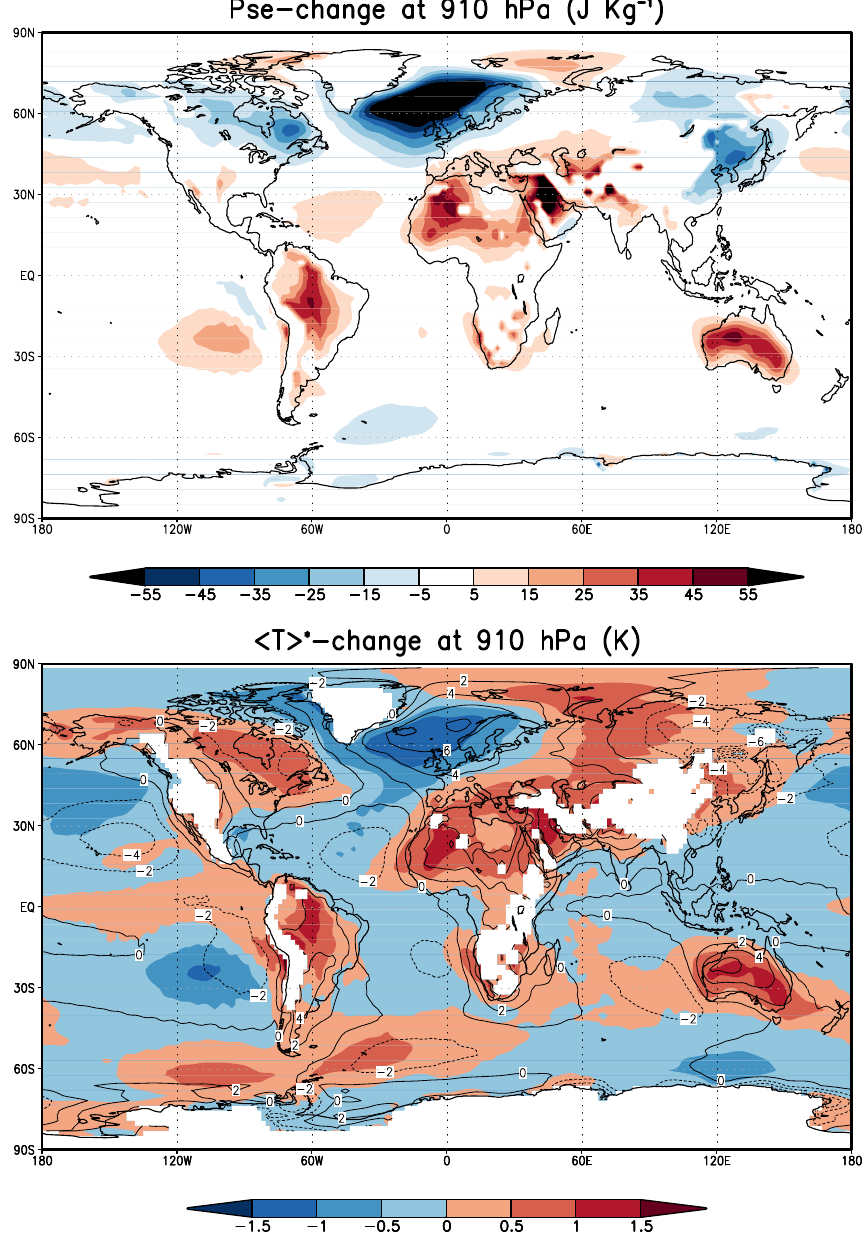
Fig. 9. P se -change (upper panel) and h T i ∗ -change, the changes in the zonal anomalies of temperature (lower panel) at 910hPa due to CO 2 doubling. Contour lines in lower panel indicate the 1 × CO 2 distribution of h T i ∗